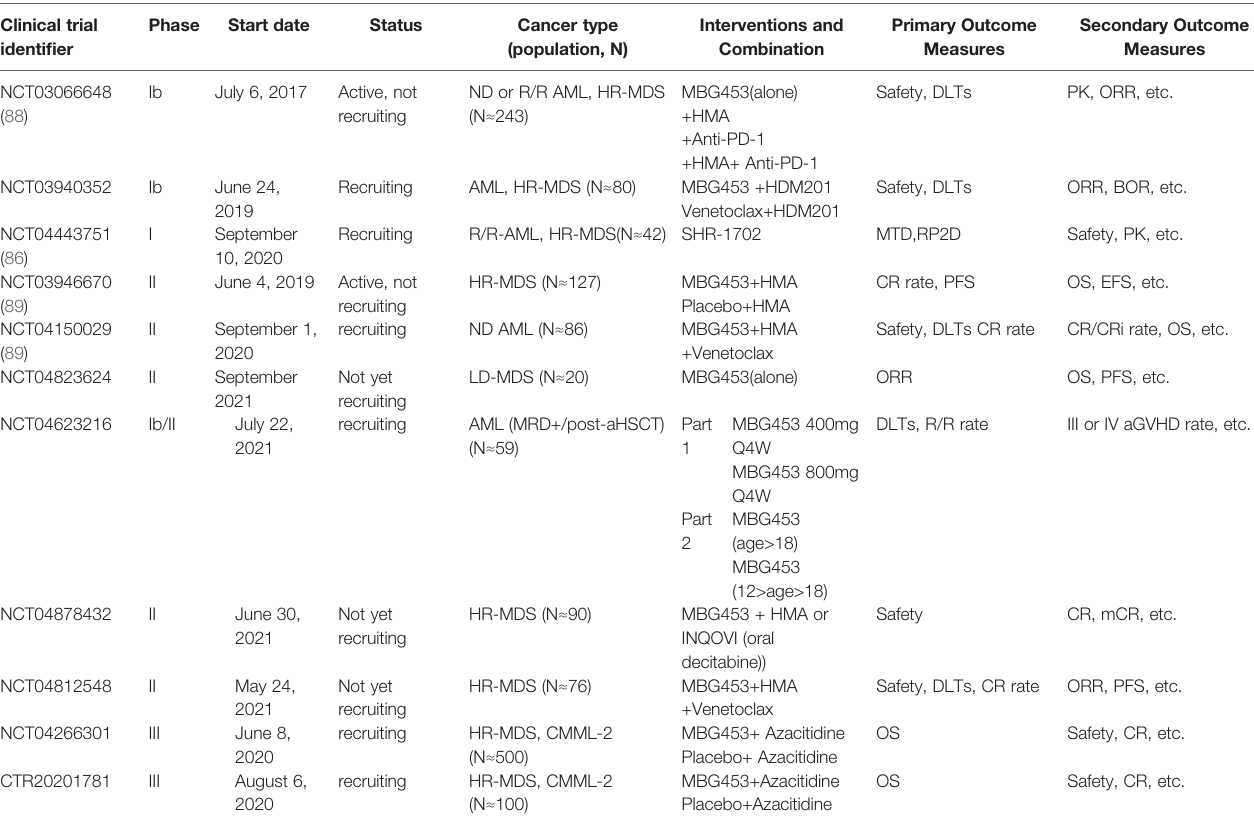
TABLE 2 | Anti – TIM-3 agents and associated clinical trials in leukemia.